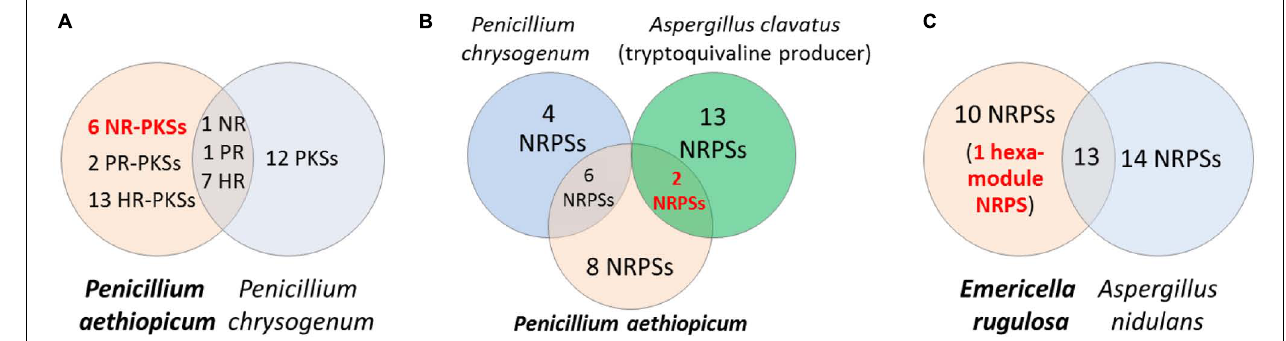
FIGURE 3 | Comparative genomics approach for discovery of SM biosynthetic gene cluster. Comparison of the PKS genes in Penicillium aethiopicum and P. chrysogenum was utilized in searching for the griseofulvin and viridicatumtoxin gene cluster (A) . In order to narrow down possible candidates for the tryptoquialanine gene cluster in P. aethiopicum , NRPS